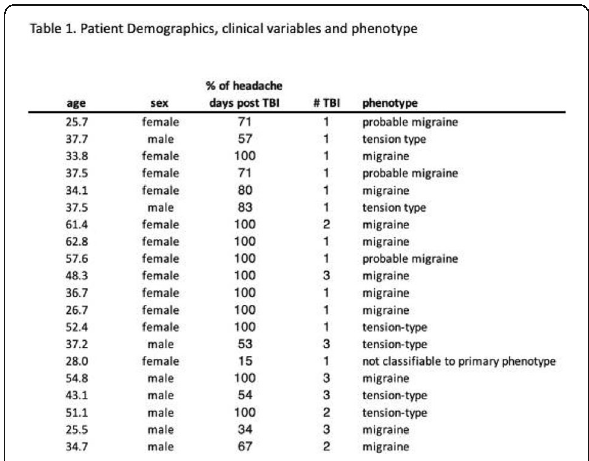
Table 1 (abstract AL030). See text for